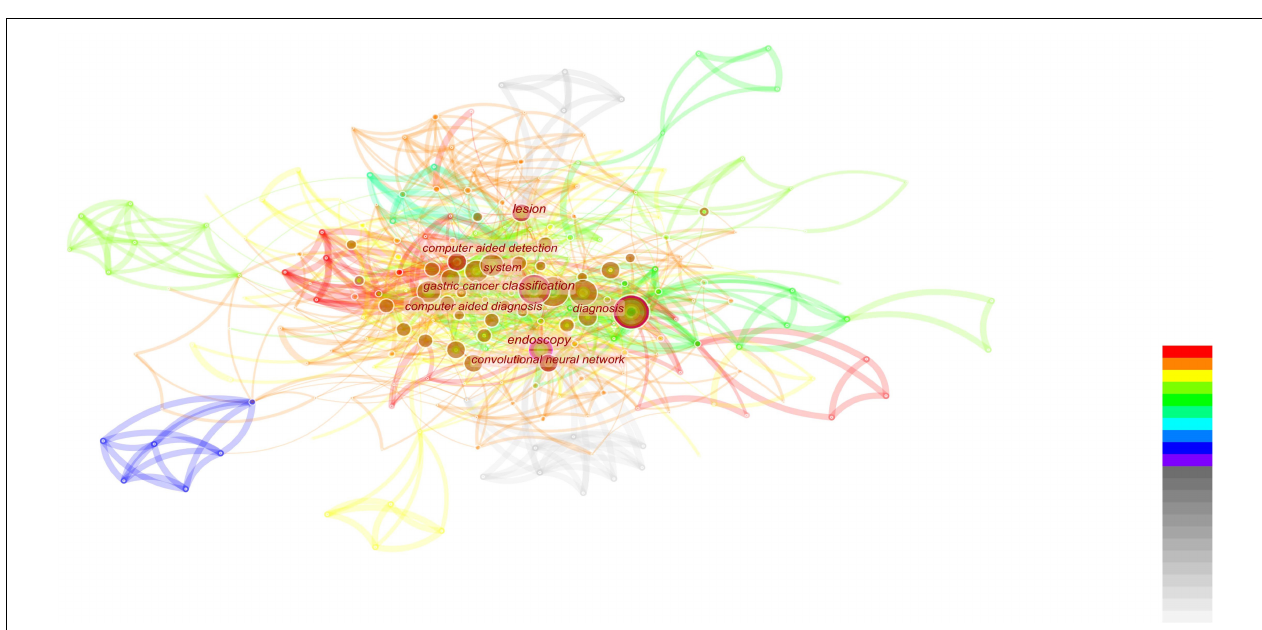
FIGURE 5 | This figure is based on the literature analysis of artificial intelligence and endoscopy. It can be seen that the research hotspots under this topic are the classification of gastric cancer and computer-aided examination and diagnosis. At the same time, convolutional neural networks also appear in hot spots, indicating that convolutional neural networks are showing an increasing trend in the application of artificial